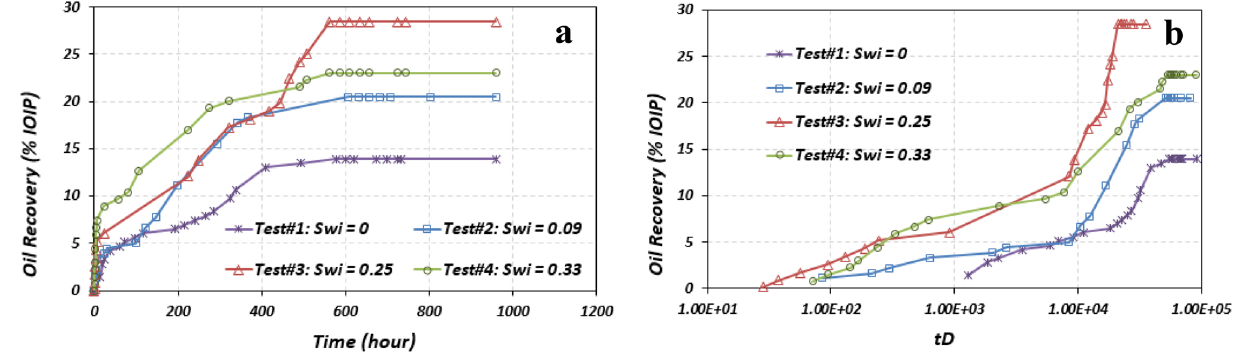
Fig. 2 Oil recovery (% IOIP) versus time resulted from spontaneous imbibition tests using carbonate cores (low permeable having various initial water saturations. Left picture ( a ) is presented